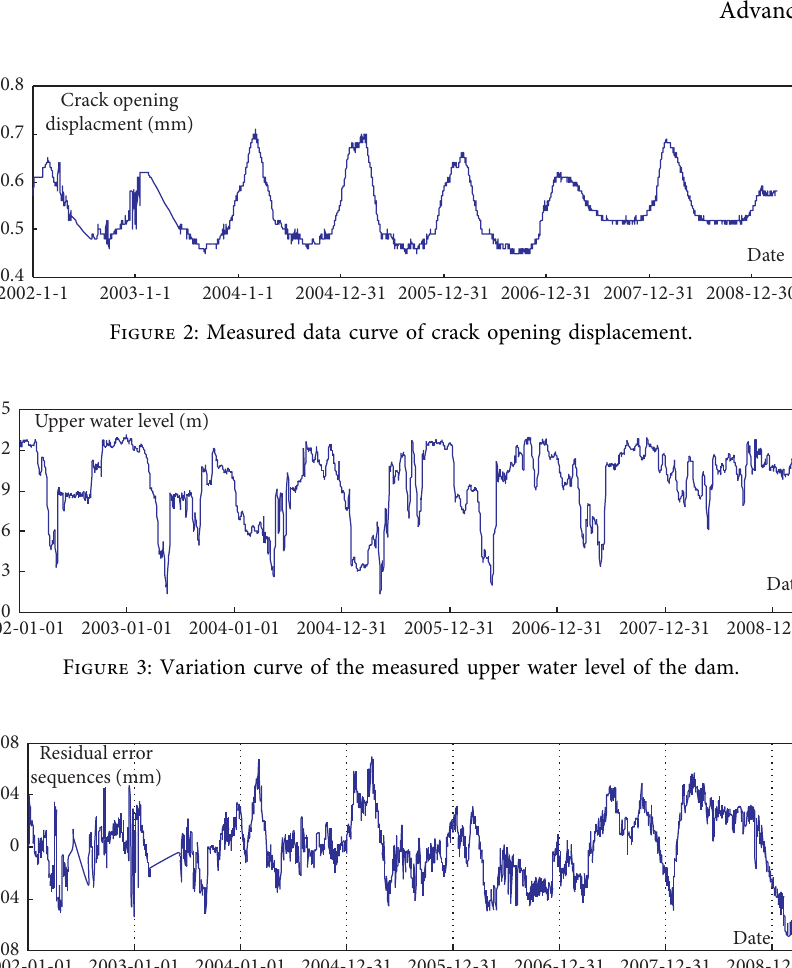
Figure 4: The residual sequences of monitoring models.